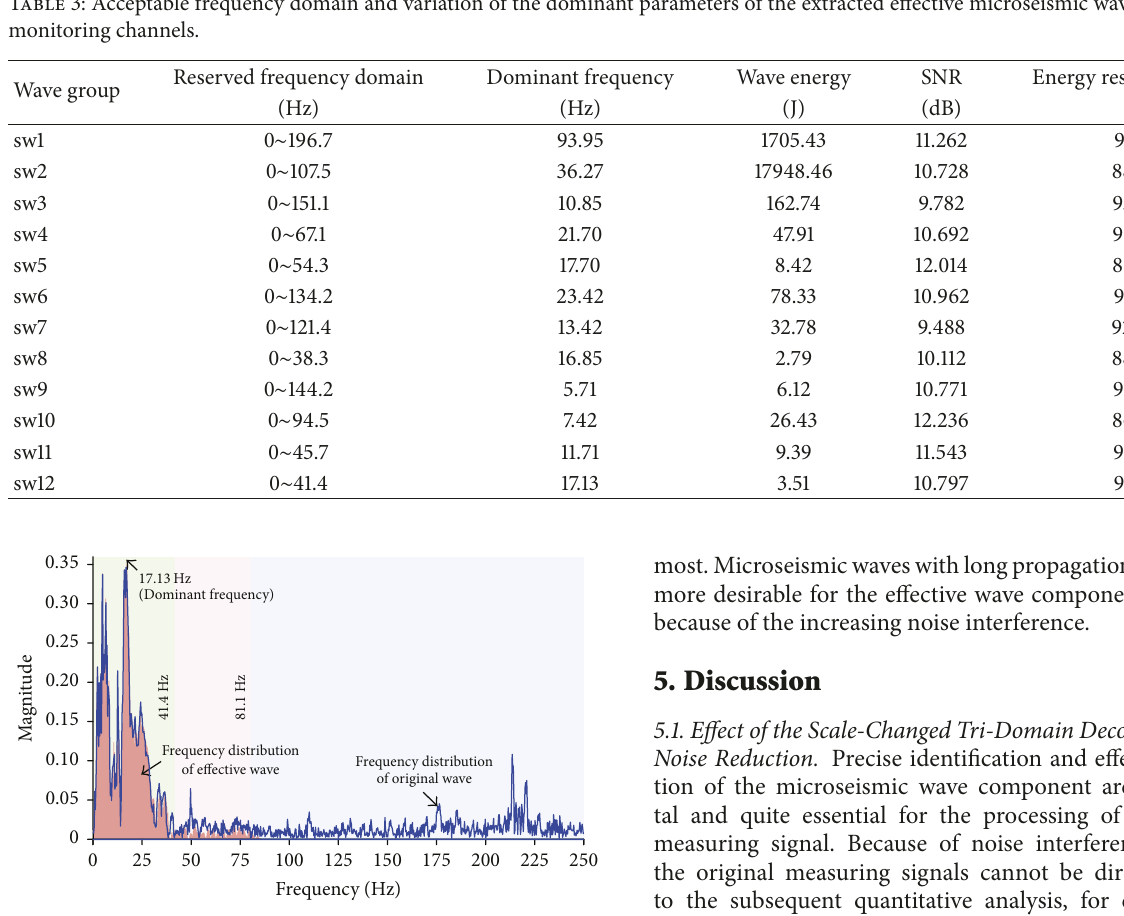
Figure 11: Comparison of the frequency spectrum of the extracted effective microseismic wave and the original measured